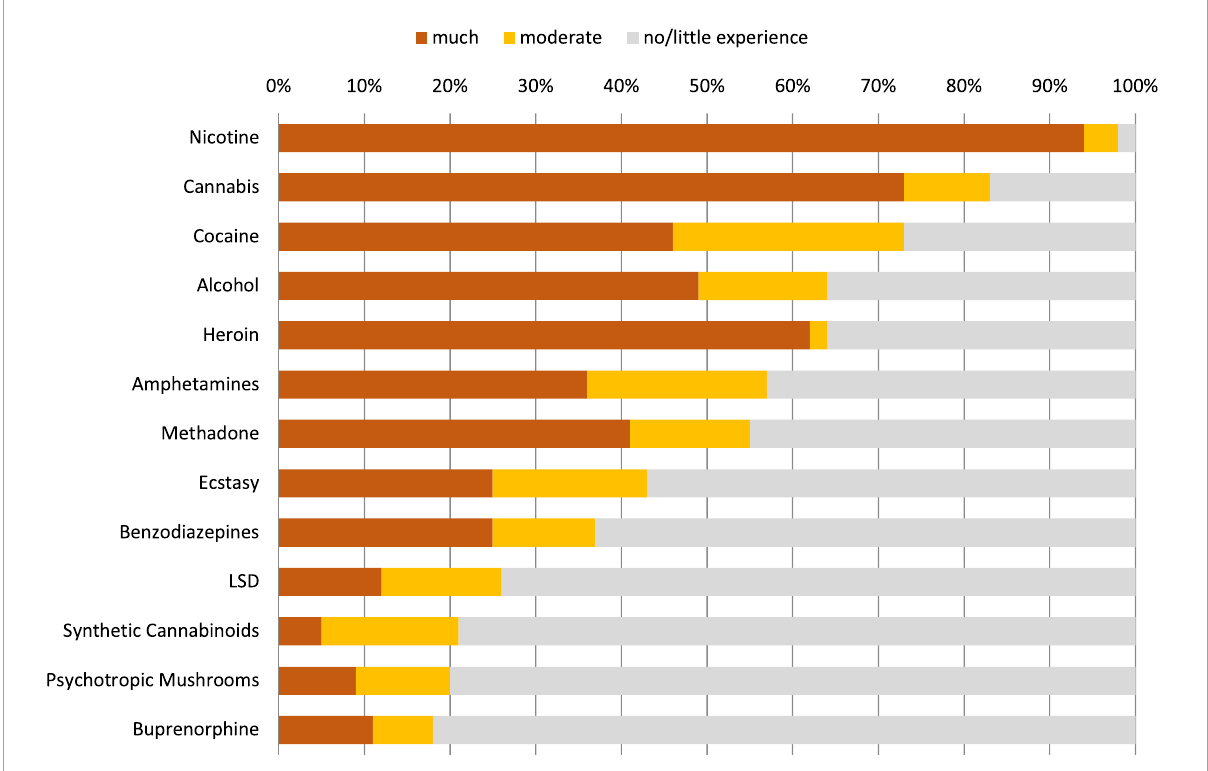
FIGURE2 Users’ experience regarding the evaluated substances in cohort 1. The “core group” (defined by < 50% “no/little”-experience data and > 50% ratings per substance) comprised the substances nicotine, cannabis, cocaine, alcohol, heroin, methadone, and amphetamines. Extended version in Supplementary Figure 16